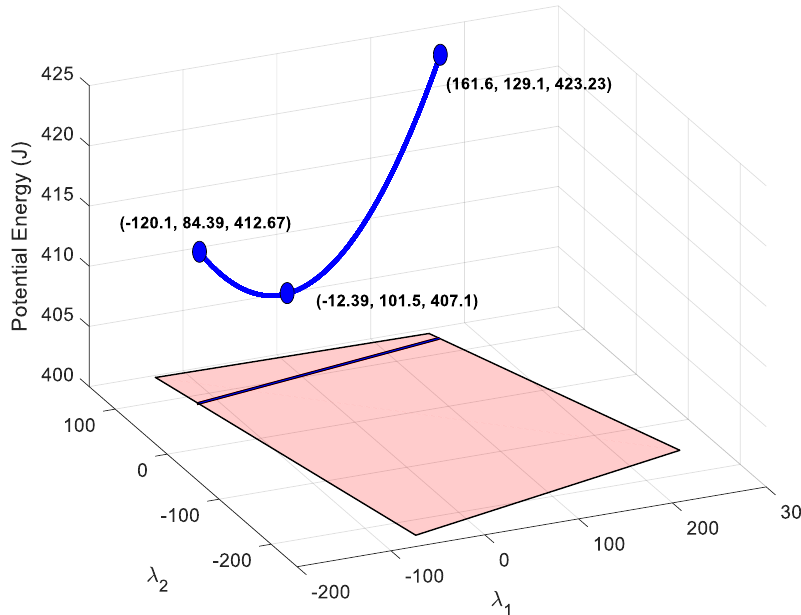
Figure 9. The blue 3D curve represents the potential energy stored in all cables that can be achieved by maintaining the condition of setting a deformation in the cable 8 of 0.2 m. The projection of this curve over the horizontal plane provides feasible nullspace variables. Coordinates are [ 𝛌 𝟏 , 𝛌 𝟐 , U ].